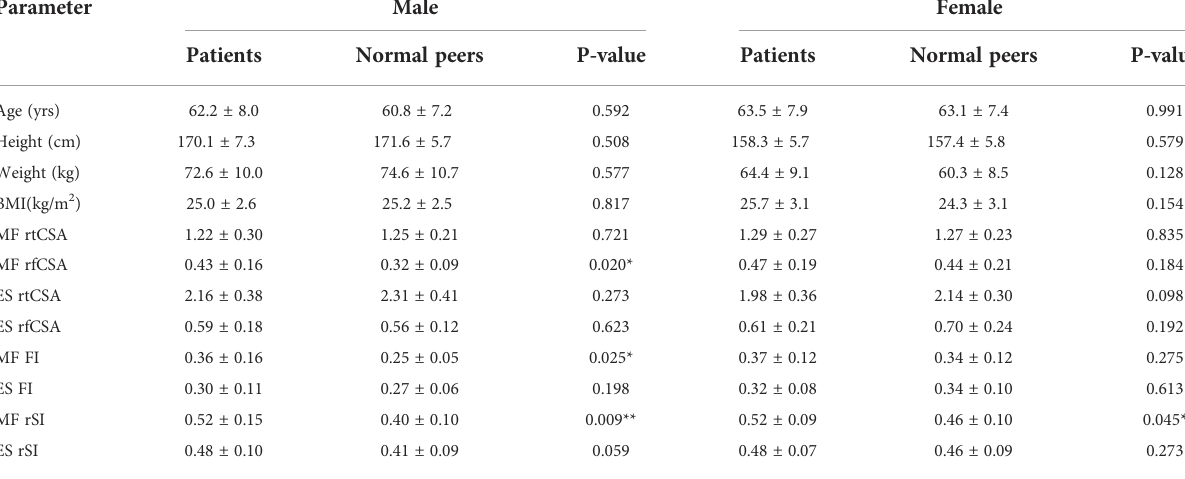
TABLE 5 Comparison of paraspinal muscle parameters between patients and normal peers under different gender. Parameter Male Patients Normal